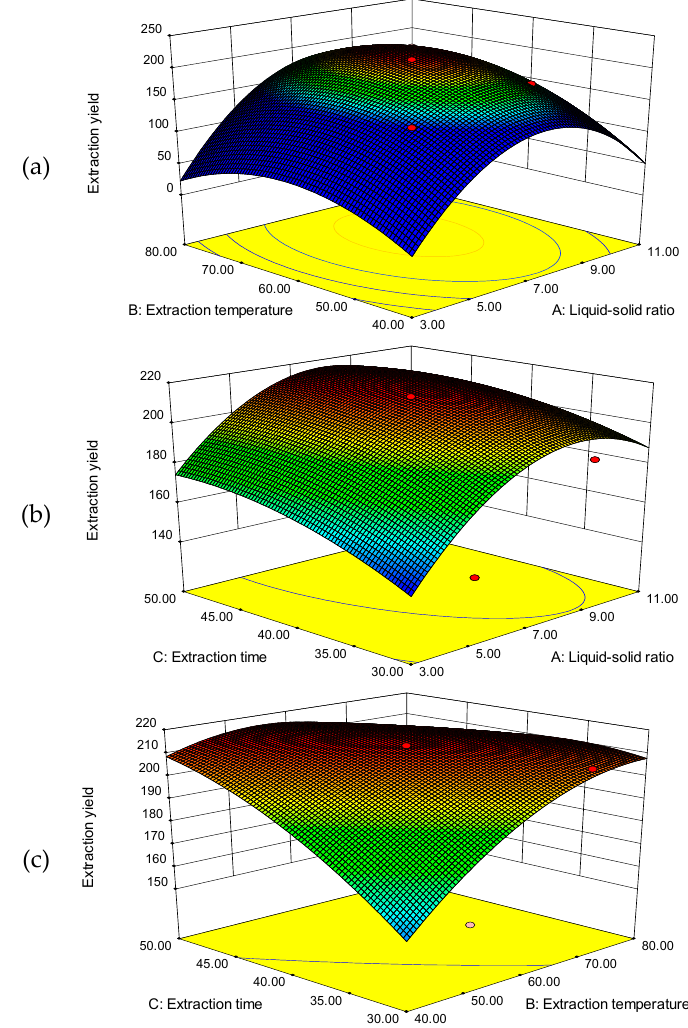
Figure 3. Response surface curves for the effects of ( a ) liquid–solid ratio and extraction temperature, ( b ) liquid–solid ratio and ultrasonic extraction time, and ( c ) extraction temperature and ultrasonic extraction time on the extraction yield of zeaxanthin.